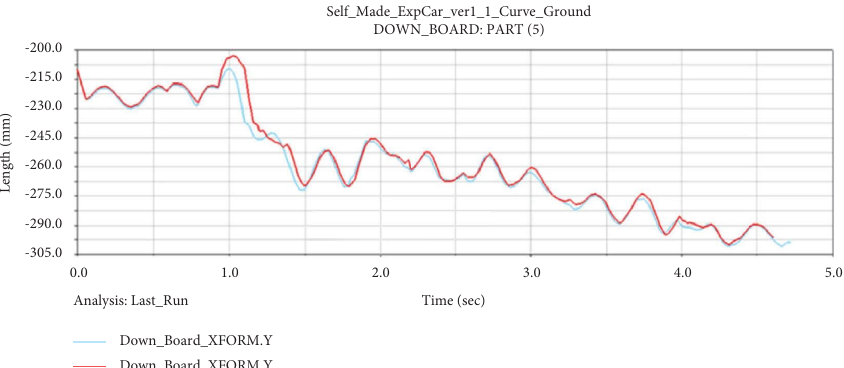
Figure 6: Adams motion simulation results.